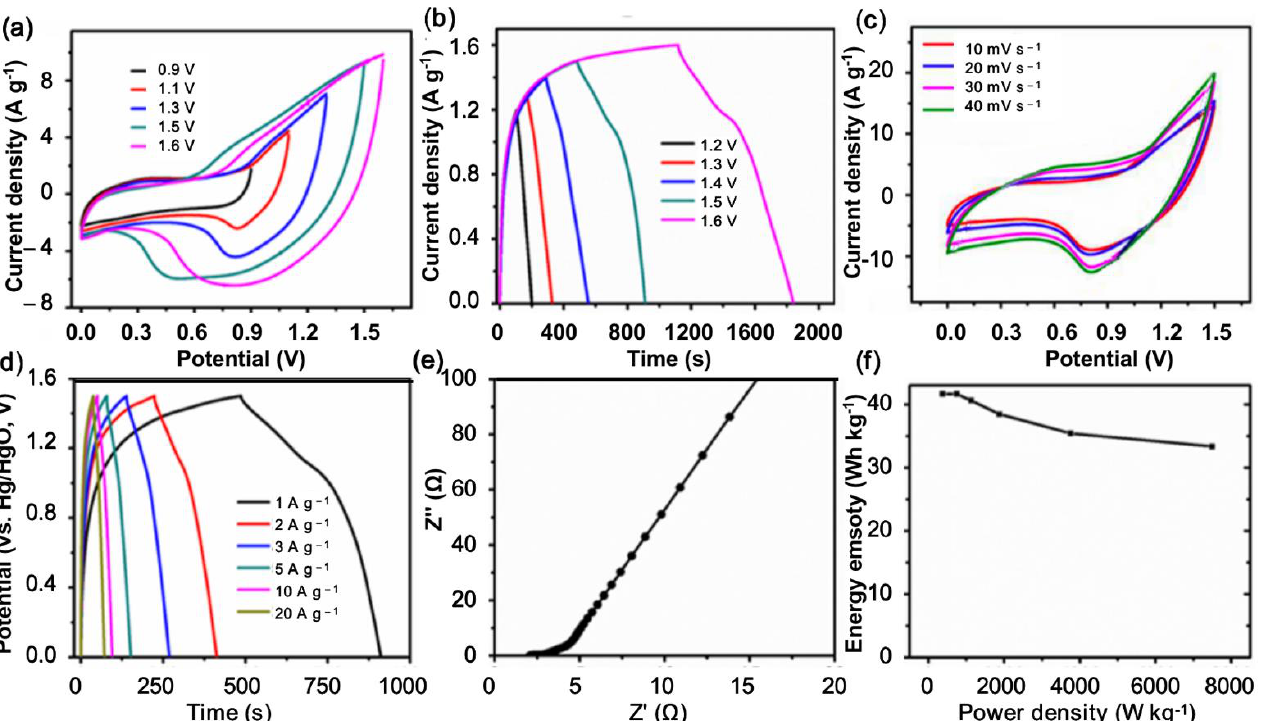
Figure 4. ( a ) CV curve of asymmetric supercapacitor apparatus at different window potential; ( b ) GCD profile of ASC at various cell voltages (1 A/g); ( c ) CV curves of ASC at different scanning rates; ( d ) GCD curve of ASC at different current densities; ( e ) EIS spectrum of fabricated ASC device; ( f ) power density – energy density relationship of a prepared asymmetric supercapacitor (Ragone diagram).